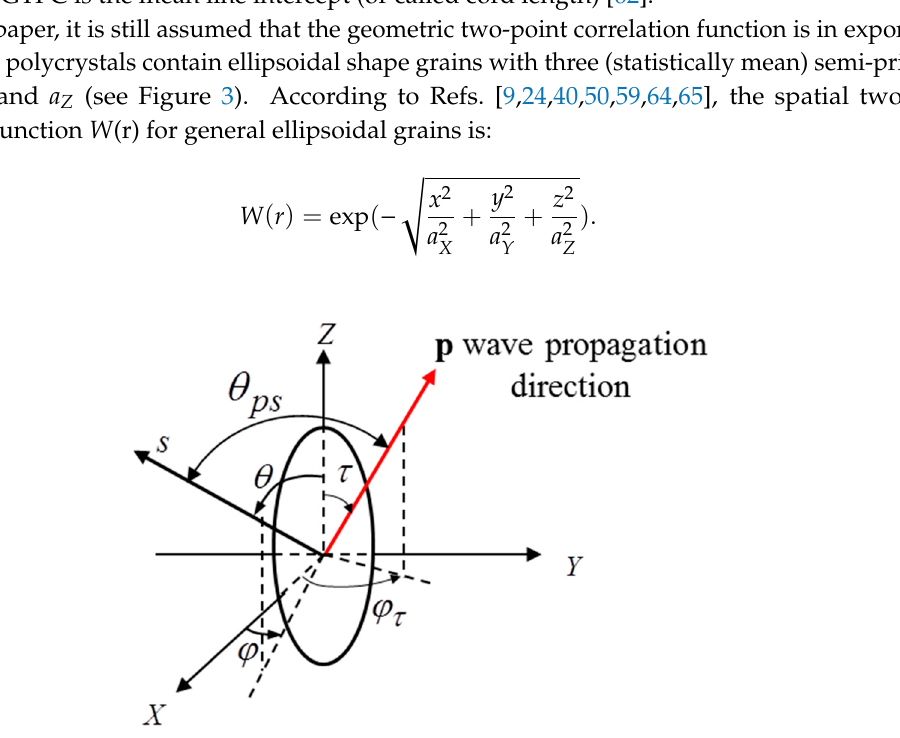
𝒑(𝜏,𝜙 ) and 𝒔(𝜃, 𝜙) . (cid:3043)(cid:3046) is the angle between (cid:3099)